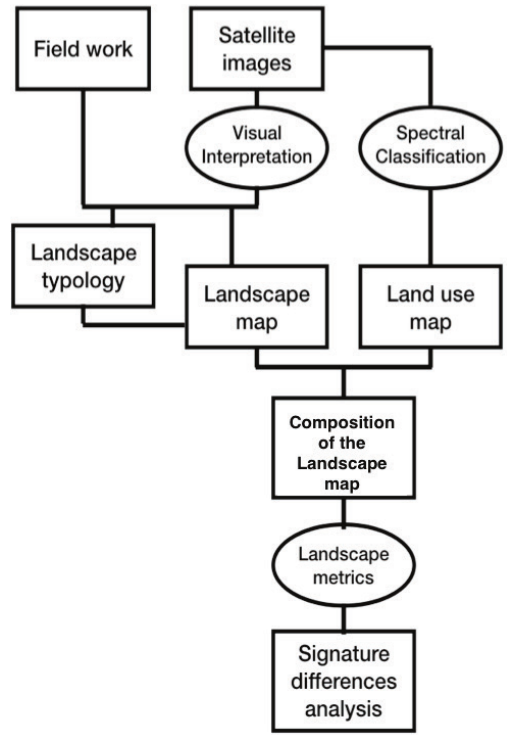
Figure 2: Overview of the methodological